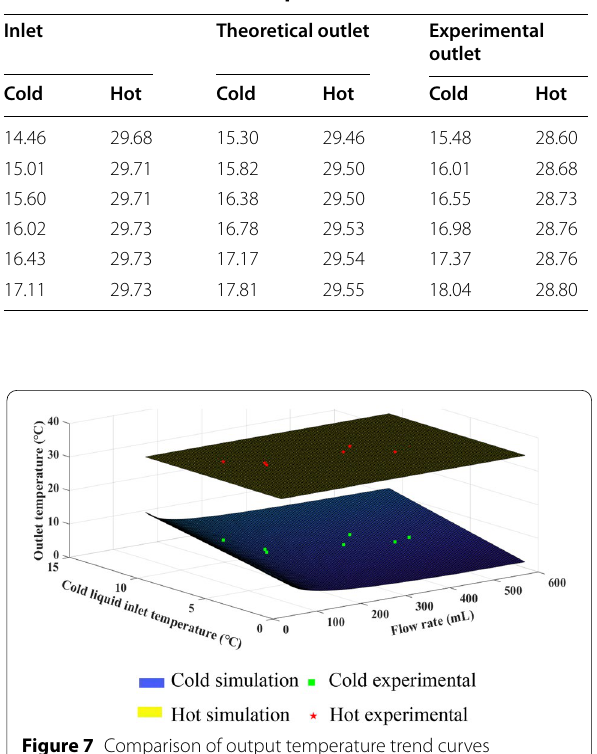
Table 8 Inlet and outlet temperatures (°C)